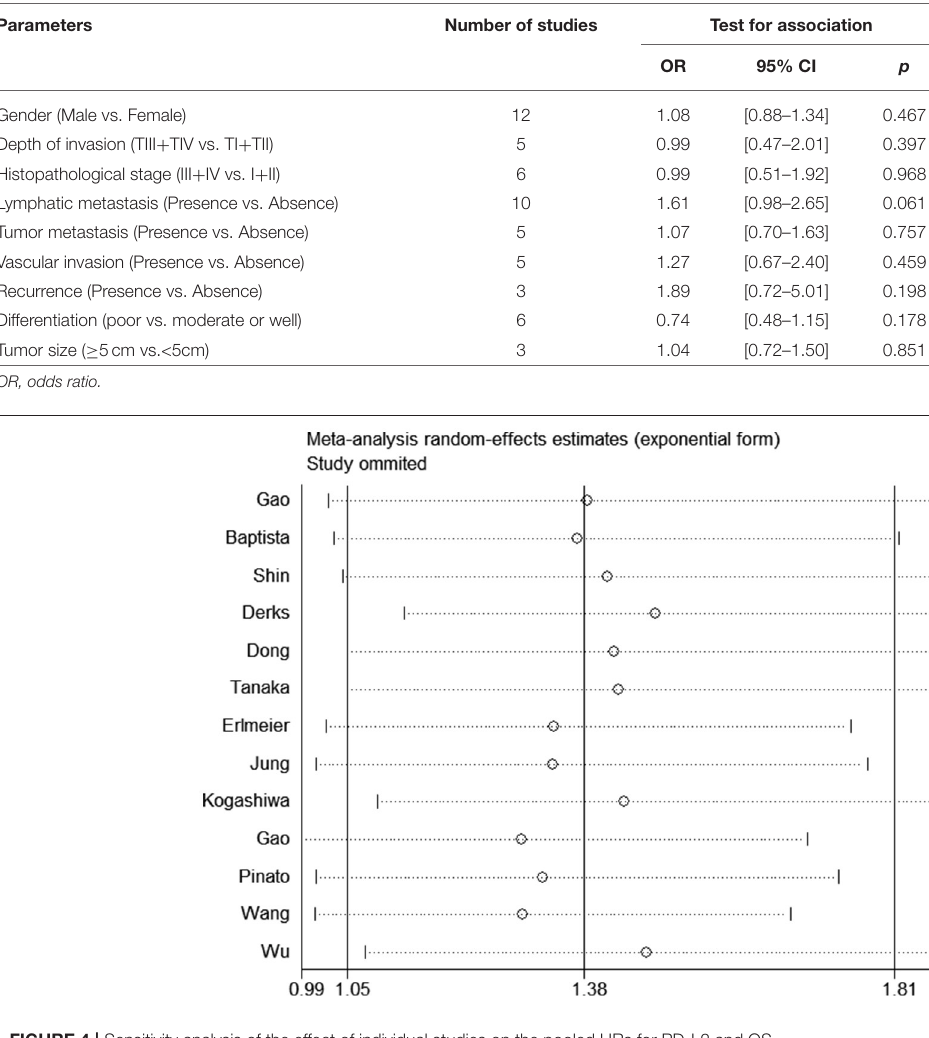
FIGURE 4 | Sensitivity analysis of the effect of individual studies on the pooled HRs for PD-L2 and